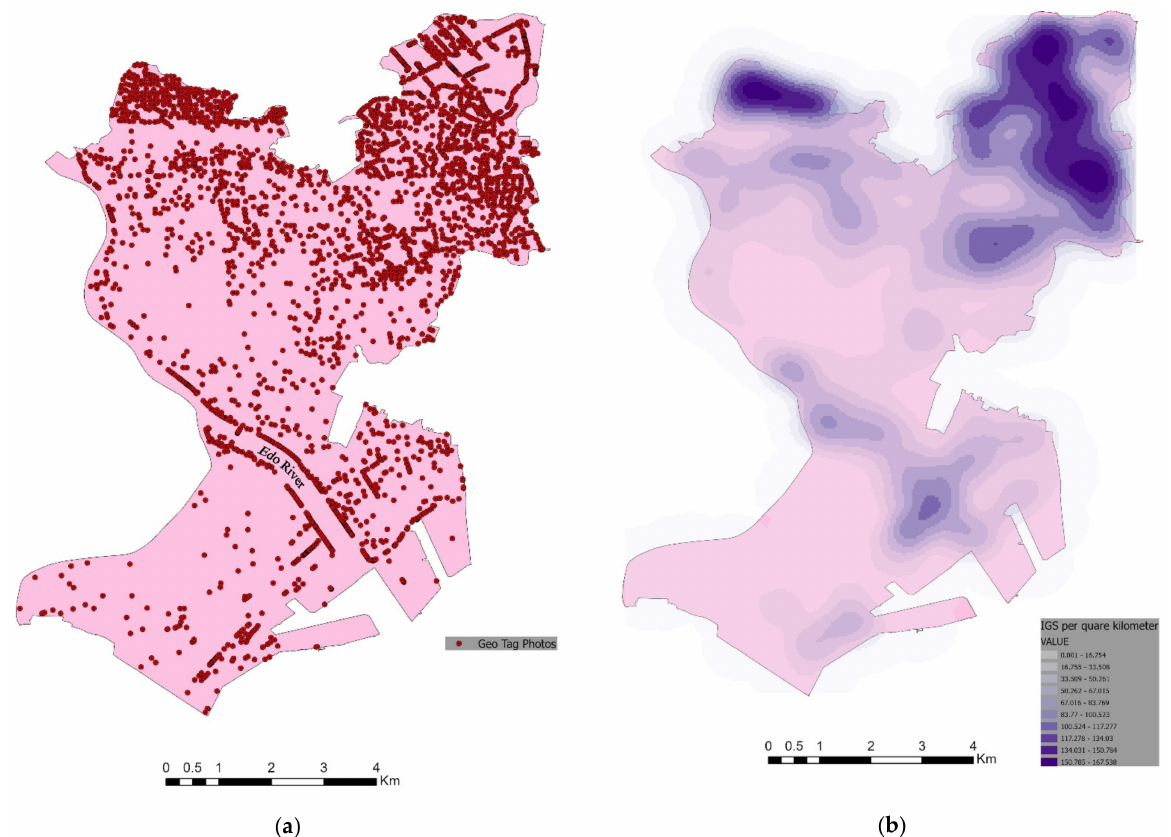
Figure 9. Distribution map ( a ) and density map ( b ) of IGSs in Ichikawa. The IGSs are concentrated in the northwest, east, and along the Edo River but are scattered in the city’s center and southeast. Southwest Ichikawa has a few IGSs, and some places have no IGSs. The hotspots in the density map are indicated by a dark purple color, representing a high density of IGSs in the northwest and northeast of